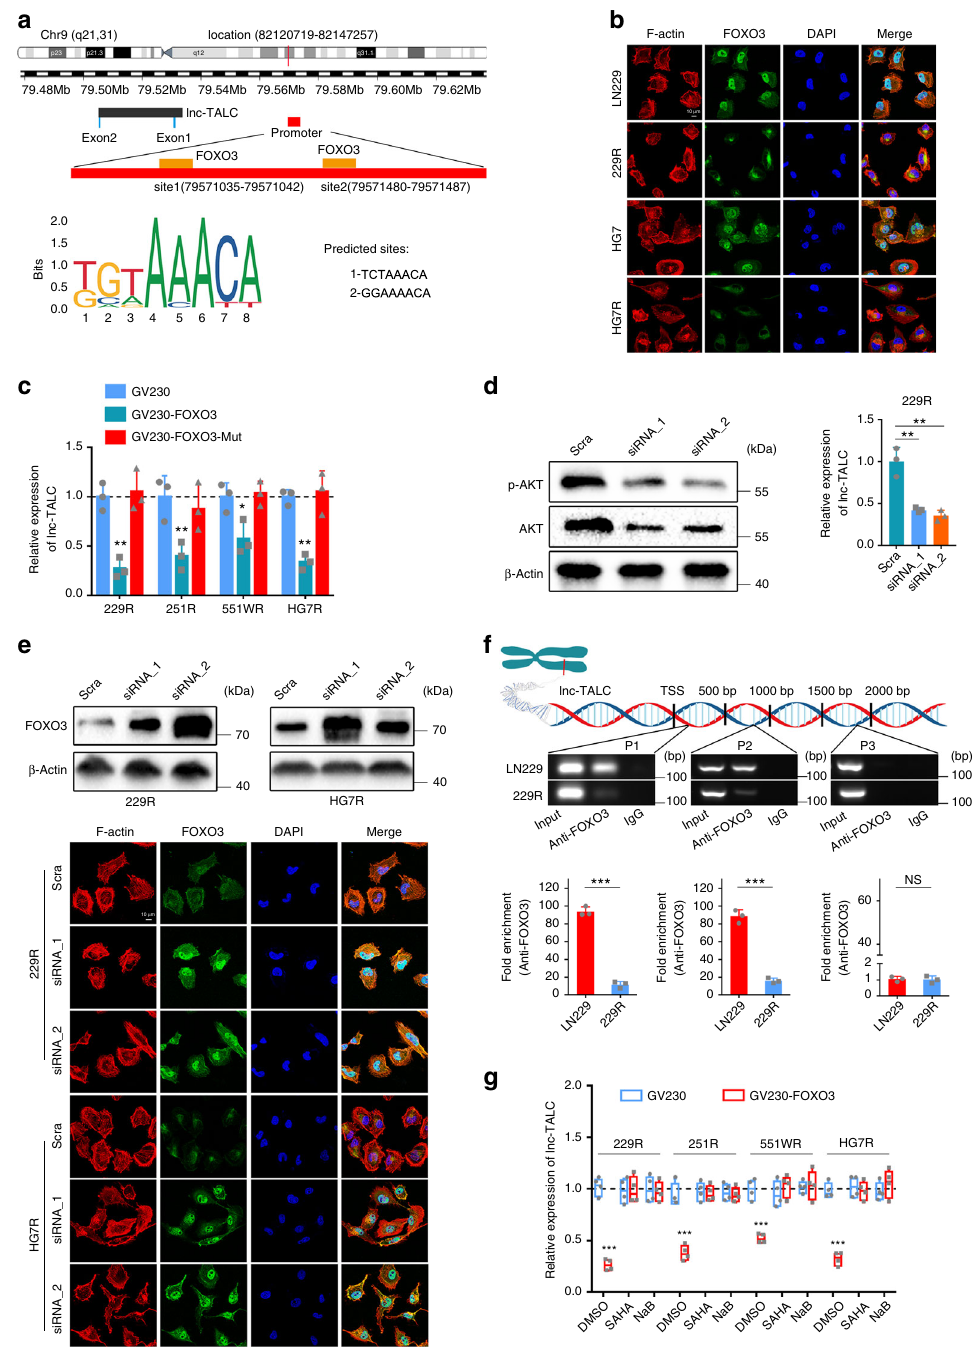
Fig. 3 Phosphorylated AKT and the FOXO3 axis regulates lnc-TALC expression in TMZ-resistant GBM cells. a Predicted FOXO3-binding sites in the promoter region of lnc-TALC. b Immuno fl uorescence analysis of FOXO3 in TMZ-resistant and parental GBM cells. The nuclei were stained with DAPI. Scale bar = 10 μ m. c qRT-PCR analysis of lnc-TALC levels in TMZ-resistant GBM cells transfected with FOXO3 and FOXO3-Mut plasmids after 72 h. d Left: Western blot analysis of indicated proteins in 229R cells transfected with scramble or AKT siRNA after 72 h. Right: qRT-PCR analysis of lnc-TALC in AKT siRNA and scramble TMZ-resistant GBM cells. e Upper: Western blot analysis of FOXO3 in TMZ-resistant GBM cells transfected with scramble or AKT siRNA after 72 h. Lower: Immuno fl uorescence analysis of FOXO3 in AKT siRNA and scramble TMZ-resistant GBM cells. The nuclei were stained with DAPI. Scale bar = 10 μ m. f ChIP-PCR assay of the enrichment of FOXO3 on the lnc-TALC promoter region normalized to IgG in LN229 and 229R cells ( n = 3). P3 served as a negative control without DBEs for FOXO3. g qRT-PCR analysis of lnc-TALC in TMZ-resistant GBM cells treated with SAHA and NaB after transfection with GV230-FOXO3 ( n = 4). Data are presented as the mean ± S.D. P value was determined by Student ’ s t -test or one-way ANOVA. Signi fi cant results were presented as NS non-signi fi cant, * P < 0.05, ** P < 0.01, or *** P < 0.001